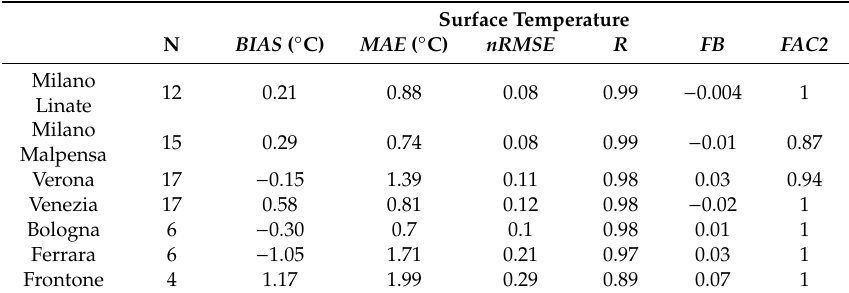
Table 2. Statistical scores of WRF surface temperature outputs related to the seven selected sites measurements. (A negative BIAS means a WRF underestimation and vice versa).